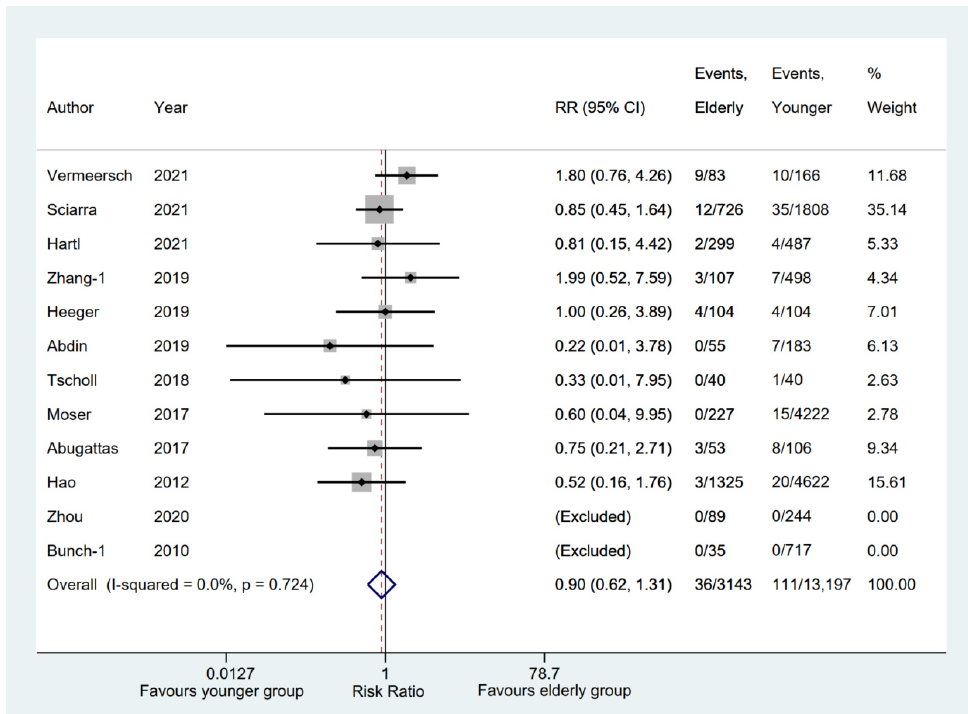
Figure 10. Forest plot comparing phrenic nerve injury between elderly and younger groups [6,11 − 13,16,17,19,21 − 23,28,29]. The dotted red line represents the pooled risk ratio for phrenic nerve groups [6,11–13,16,17,19,21–23,28,29]. The dotted red line represents the pooled risk ratio for phrenic injury between elderly and younger groups. nerve injury between elderly and younger